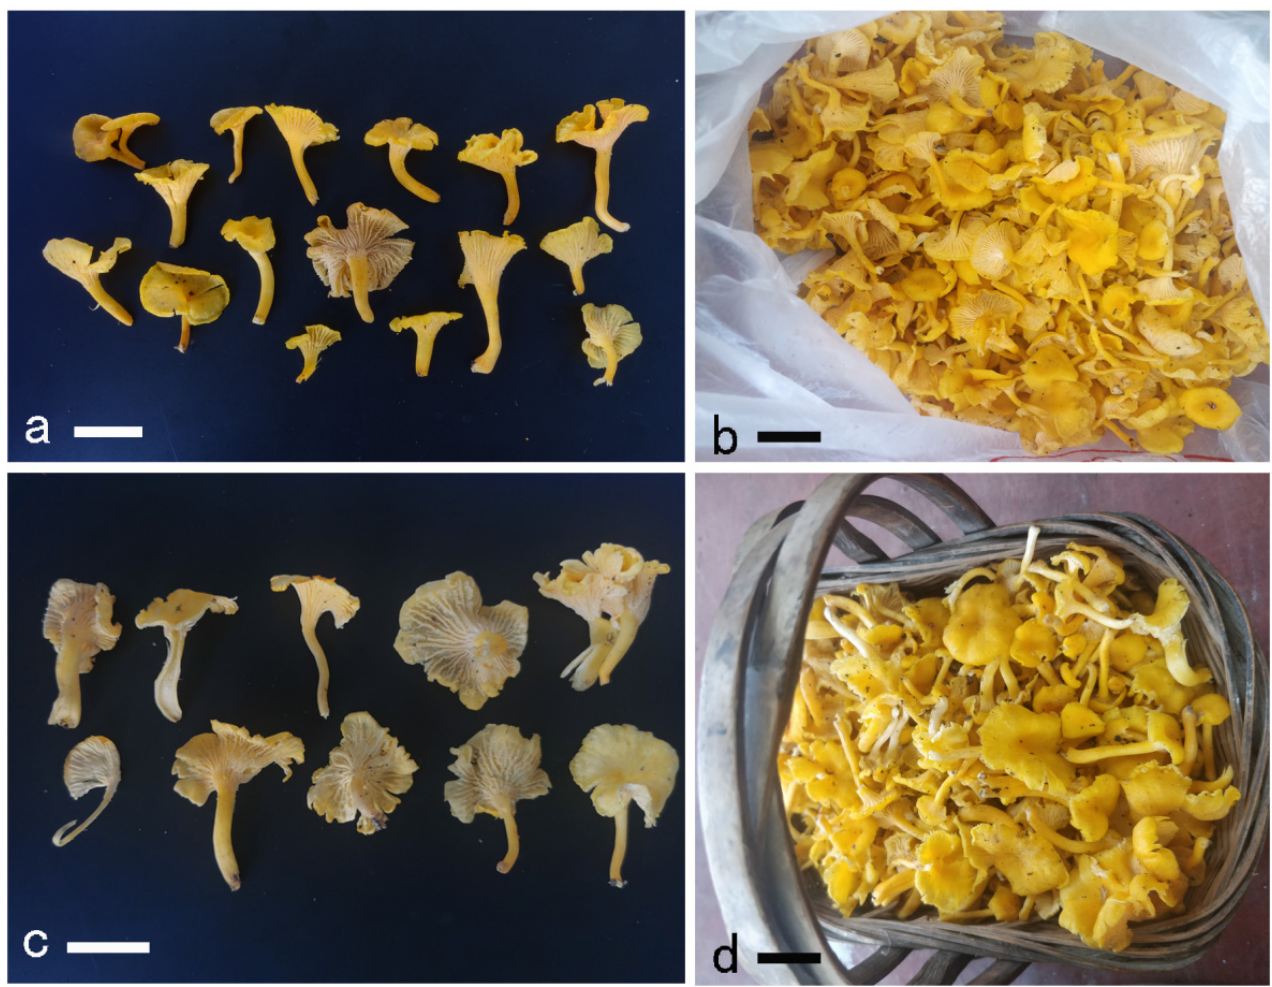
Figure 8. Basidiomata of Cantharellus citrinus . ( a , b ) GDGM86143. ( c ) GDGM86141. ( d ) GDGM80723. Bars = 2 cm.